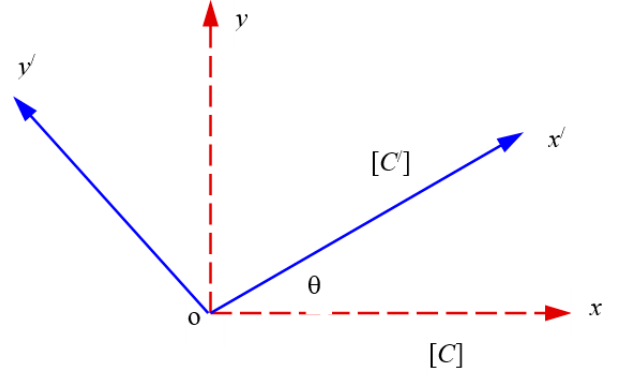
Figure A2. Rotation of the coordinate system along z -direction.